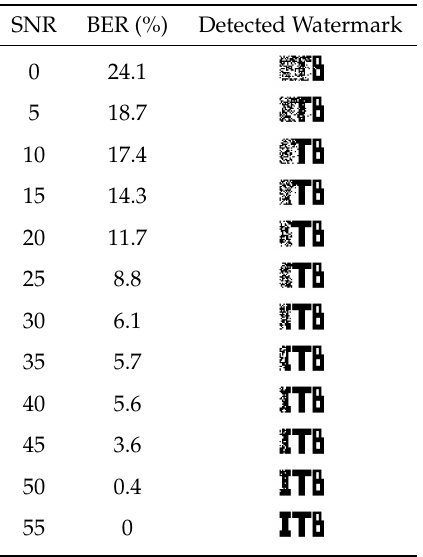
Figure 7. Additive noise effect and the detected watermark in certain SNR. Table 7. The detected watermark in certain